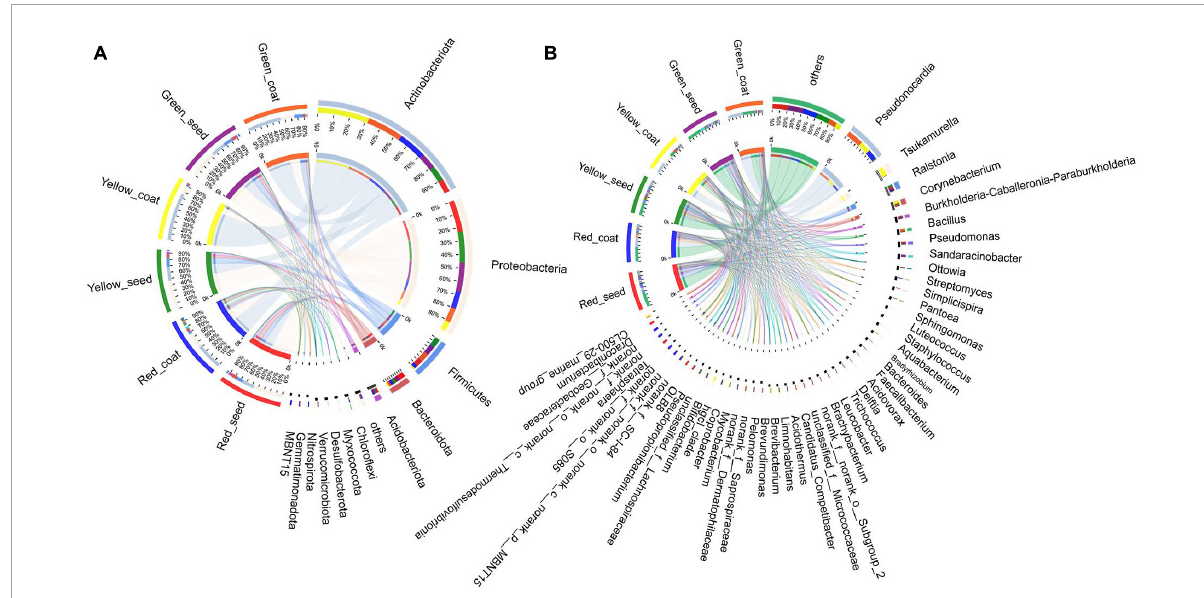
FIGURE3 The composition of most dominant endophytic bacterial communities at the phylum (A) and genus levels (B) under different treatments ( n =